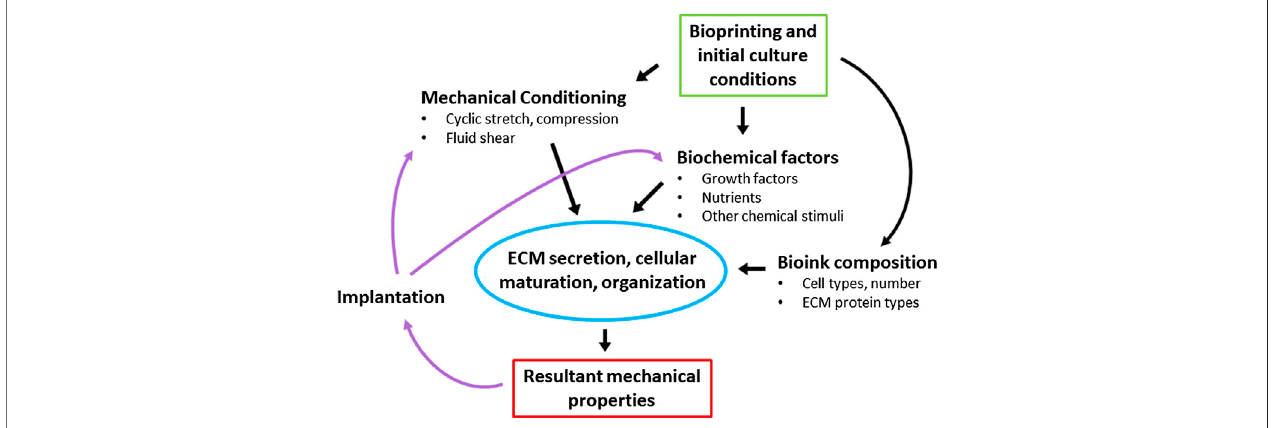
Figure 1 | The dynamics of tissue maturation. Initial determination of bioink composition, mechanical stimulation parameters, and biochemical stimuli will direct tissue remodeling and the resultant mechanical and functional properties of the tissue. This dynamic process continues after implantation, as the biological environment (mechanical and biochemical) triggers further remodeling and changes in tissue